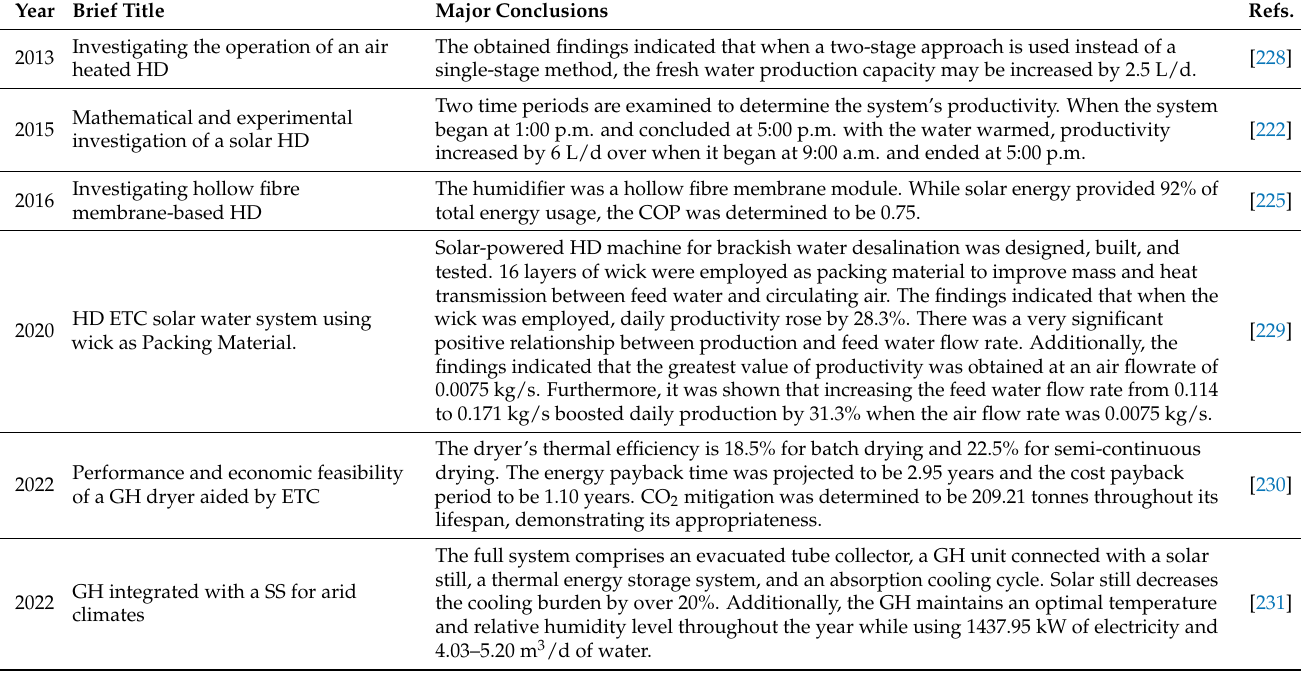
Table 6. A brief assessment of the experimental literature on the HD technique based on solar